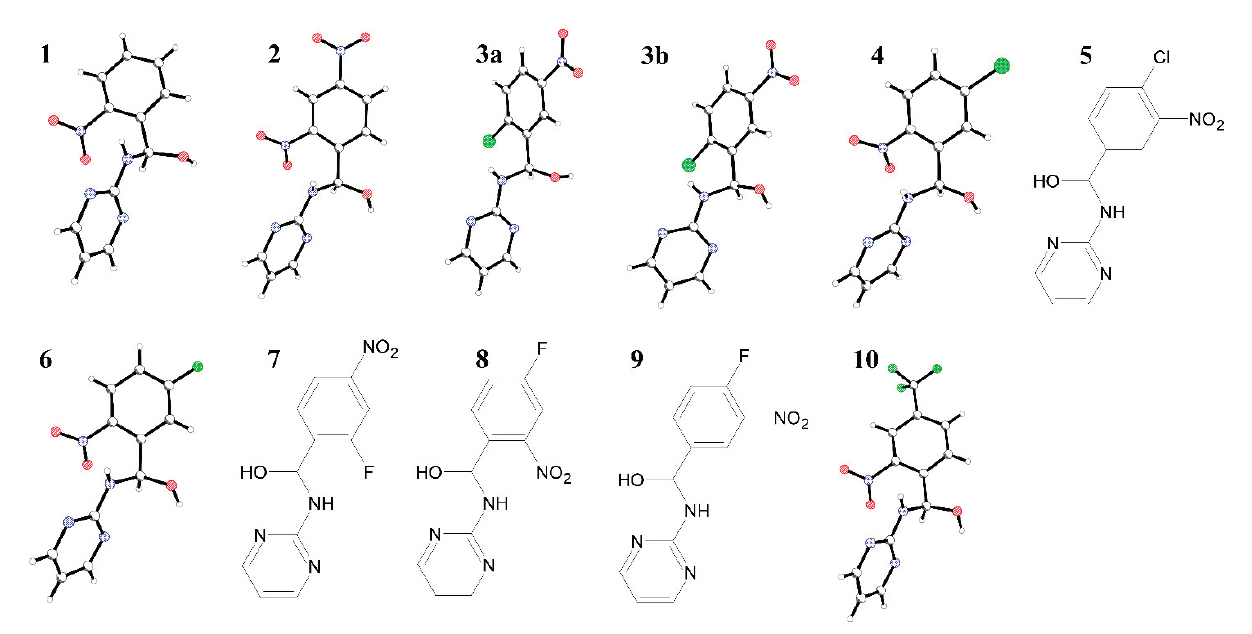
Figure 1. Molecular structures and structural formulas of the obtained